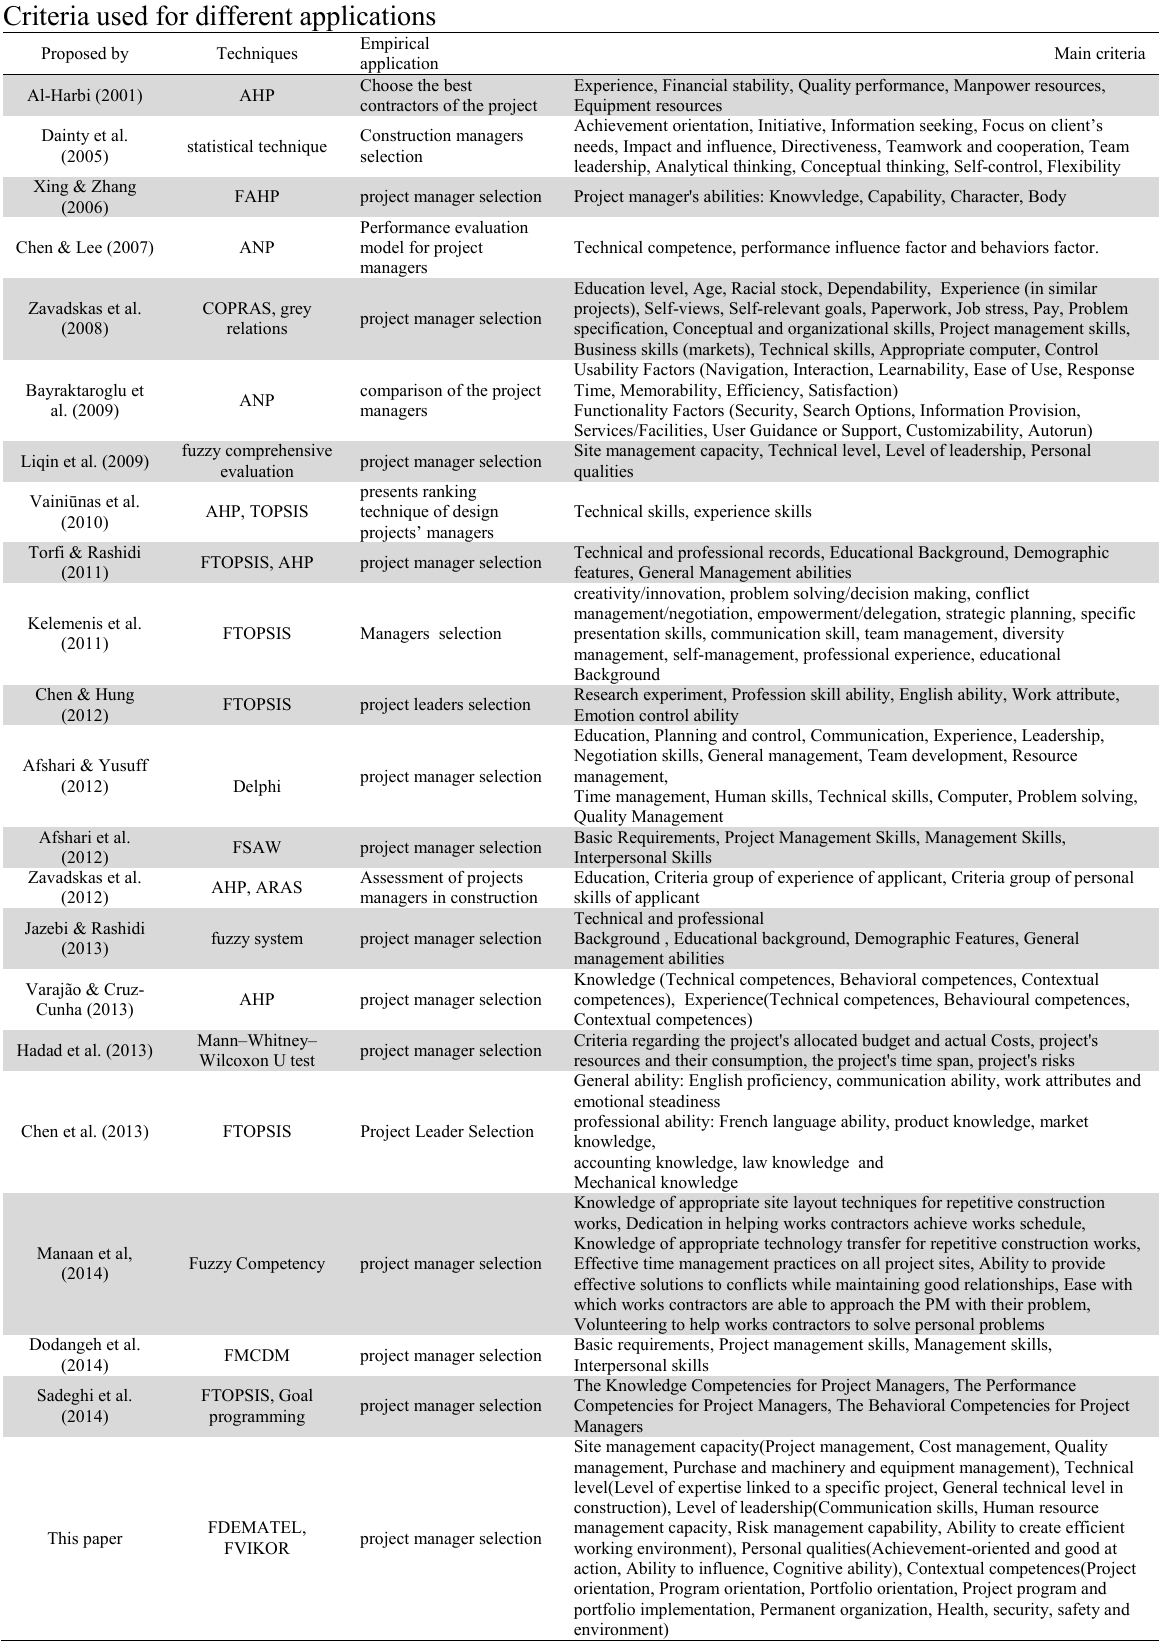
Table 1 Criteria used for different applications Proposed